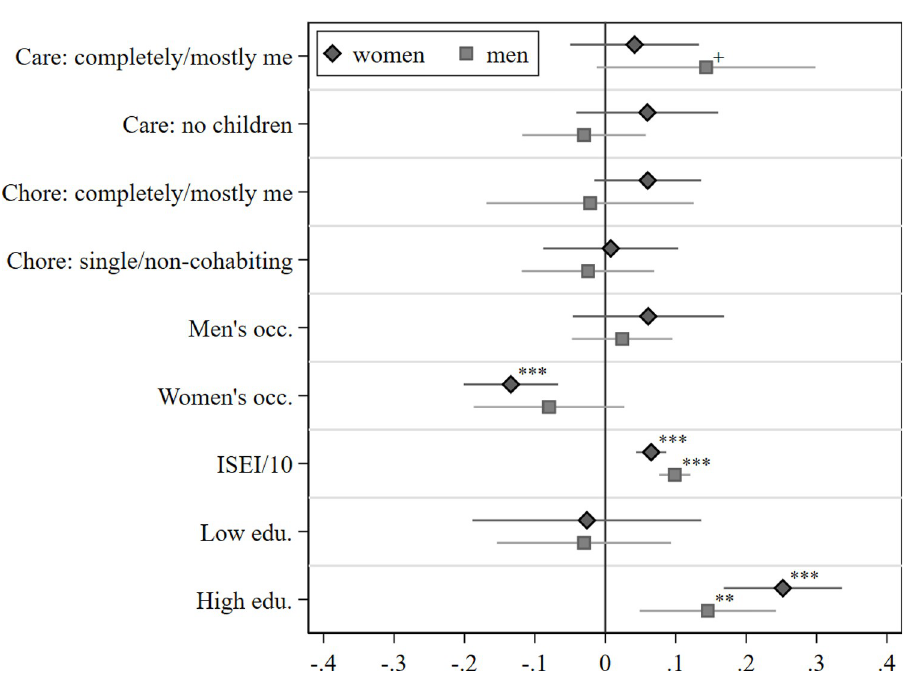
Fig 2. Work from home regressed on family responsibilities, occupational characteristics, and education. Note: Plot of Linear Probability Model coefficients (see S2 Table for the full models). Based on pairfam -COVID-19 survey and pairfam , release 12.0, and a special evaluation of the German LFS 2019, own calculations, not weighted. Reference groups: Care: split even/mostly partner/completely partner; Chore: split even/mostly partner/completely partner; mixed occupation; intermediate education. Controls (not shown): enrolled in education, East, migration background, rural, cohorts. + p < 0.10 � p < 0.05, �� p < 0.01, ��� p < 0.001.